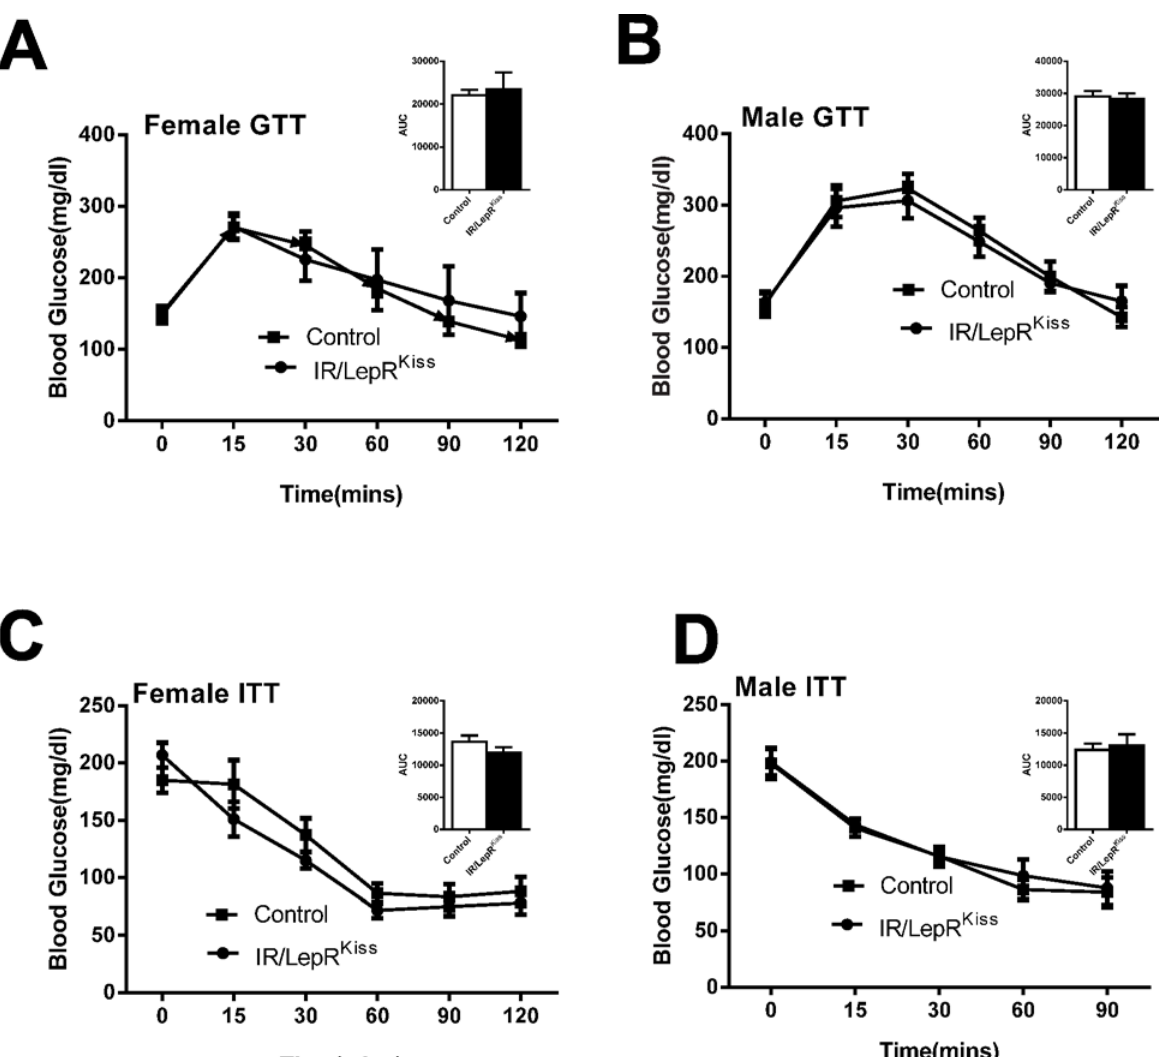
Fig 10. Glucose regulation in IR/LepR Kiss mice (A) 4 – 5 months old female GTT and area under curve (AUC) (inset) in control (n = 11) and IR/ LepR Kiss (n = 5) mice. (B) 4 – 5 months old male GTT and AUC (inset) in control (n = 10) and IR/LepR Kiss (n = 8) mice. (C) 5 – 6 months old female ITT and AUC (inset) in control and IR/LepR Kiss mice (n = 7). (D) 5 – 6 months old male ITT and AUC (inset) in control (n = 11) and IR/LepR Kiss (n = 7) mice.